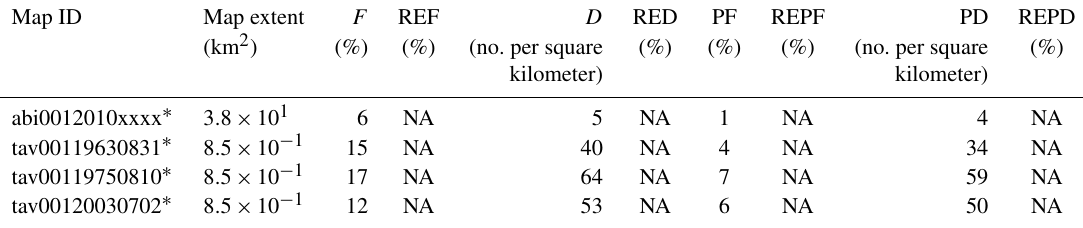
Table E3. Areal fraction and density per waterbody map in Scandinavia. Map IDs with an asterisk were not used for extrapolation. F : areal fraction of waterbodies from 1 . 0 × 10 2 to 1 . 0 × 10 6 m 2 in size; REF: relative error of fraction for map subsets of 10km × 10km; D : waterbody density per square kilometer; RED: relative error of density; PF: pond areal fraction for waterbodies from 1 . 0 × 10 2 m 2 to smaller than